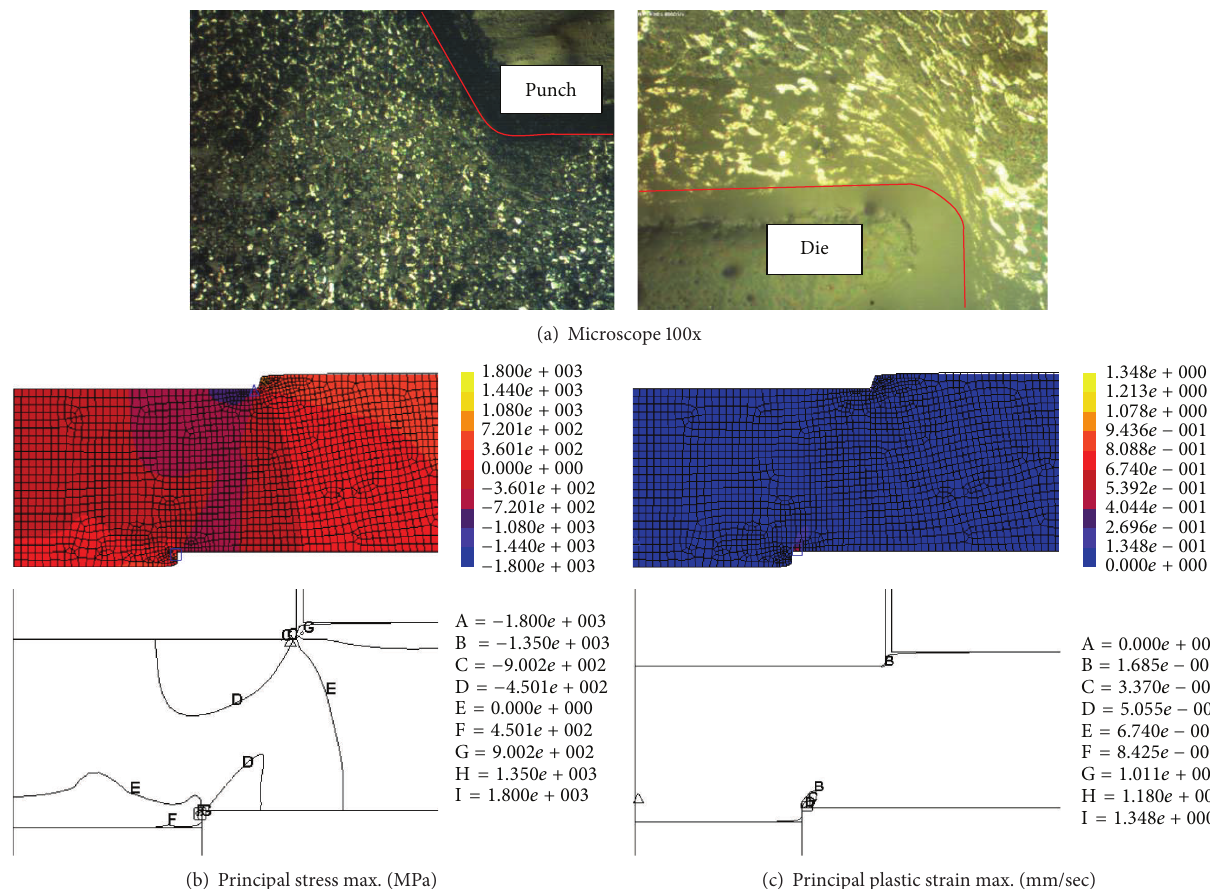
Figure 8: Microstructure behavior analysis for 20% punch penetration.